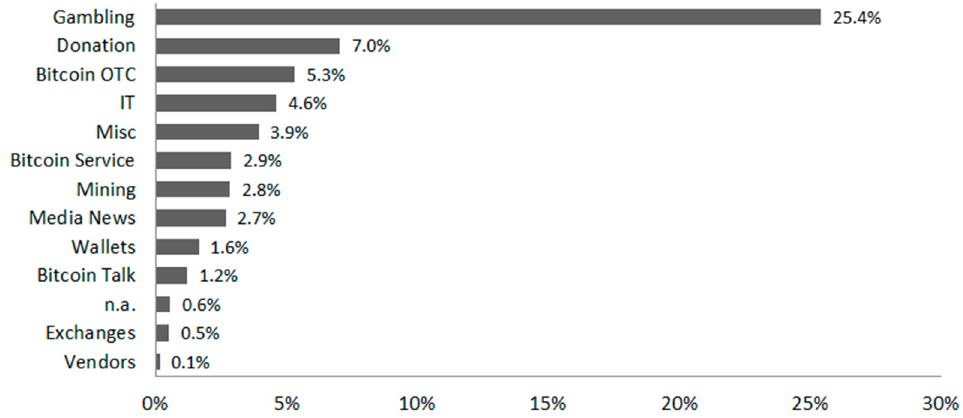
Figure 9. Transaction/Value Ratio.